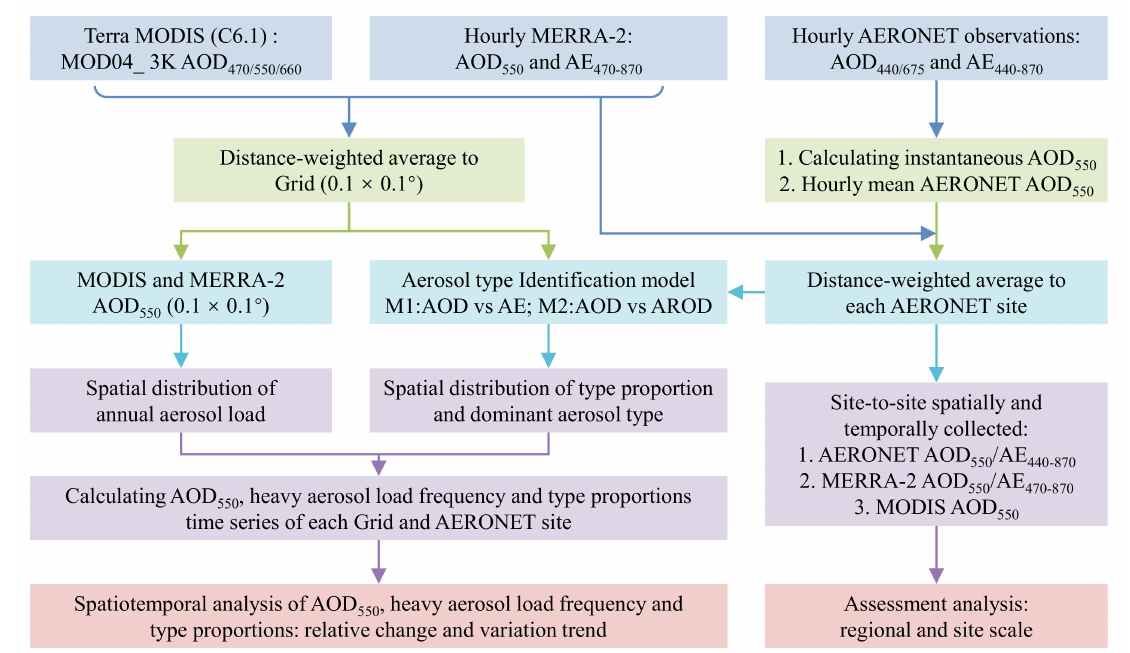
Figure 2. Workflow for evaluating aerosol load (relative change; variation trend) and identifying dominant aerosol types using MERRA-2, MODIS, and